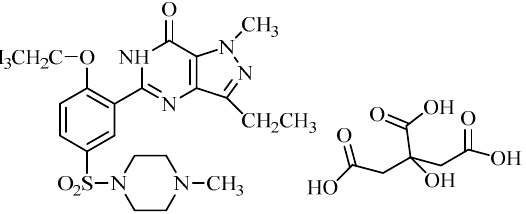
Figure 1. The chemical structure of sildenafil citrate, SC.